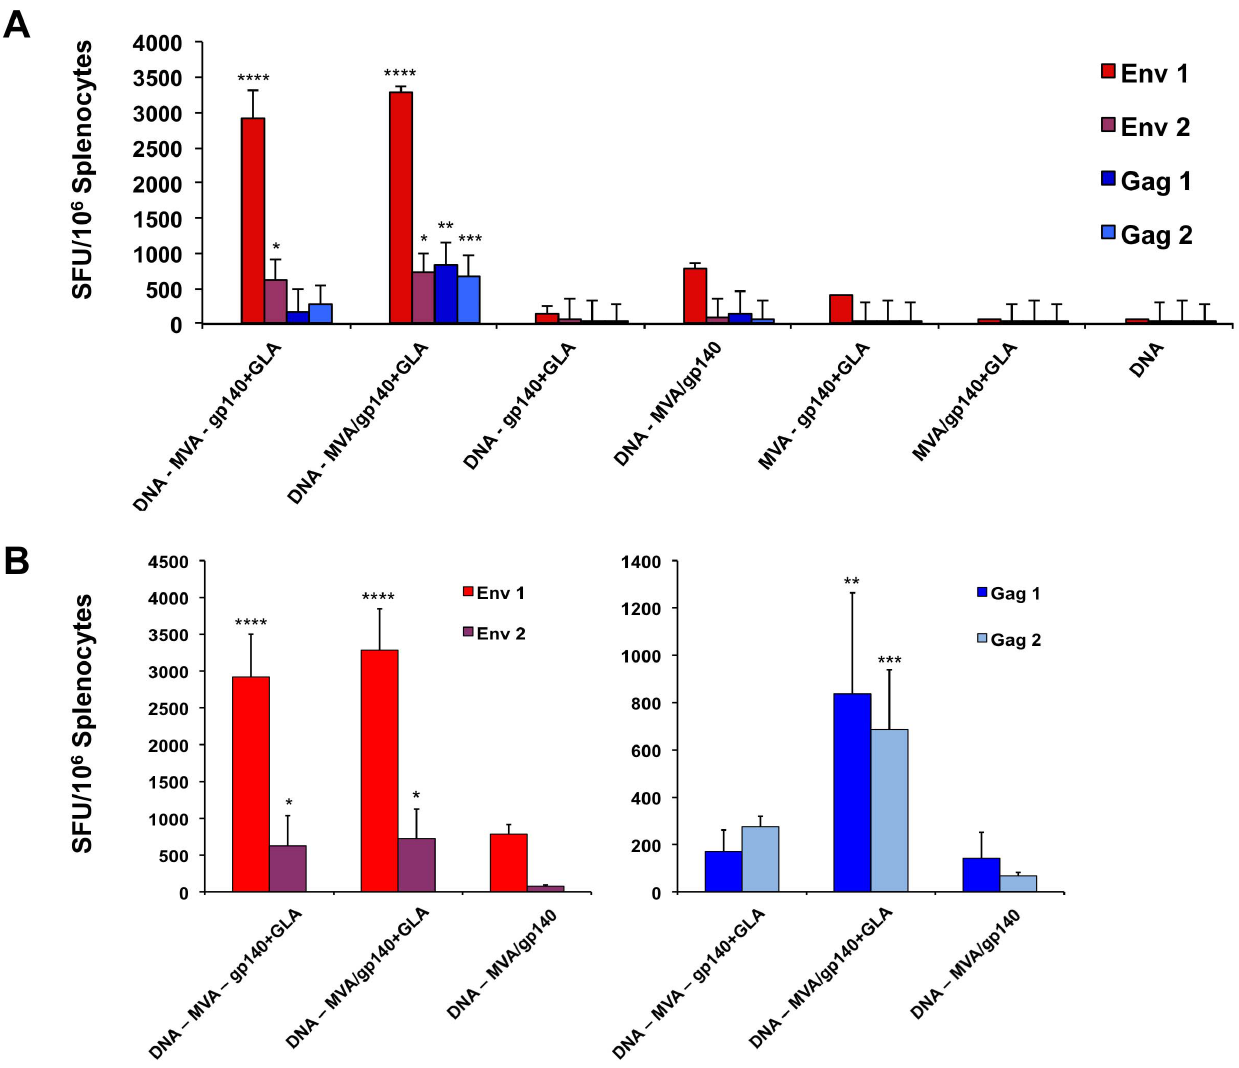
Figure 4. Splenocyte IFN- c ELISpot responses to specific vaccine antigen derived peptide pools. Cells isolated from mouse spleens at termination were stimulated with peptide pools (15 mers overlapping by 11 aa) that covered the entire coding sequence of the Gag and Env protein (two pools for each peptide) that were expressed from the transgenes present in the two plasmid DNAs and the MVA-C vector. ( A ) Specific peptide pool responses of splenocytes from all study groups. ( B ) Comparison of splenocyte IFN- c ELISpot responses to the Env and the Gag peptide pools in animals that had been DNA primed then inoculated with either MVA-C and CN54gp140 + GLA sequentially or with the MVA and protein or with all three boost vaccine components concurrently. Responses from each group of animals are shown as group mean spot forming units (SFU)/million splenocytes + / 2 SEM. Groups were statistically compared using a one-way Anova (* p , 0.05; ** p , 0.01; *** p , 0.005; **** p , 0.001).